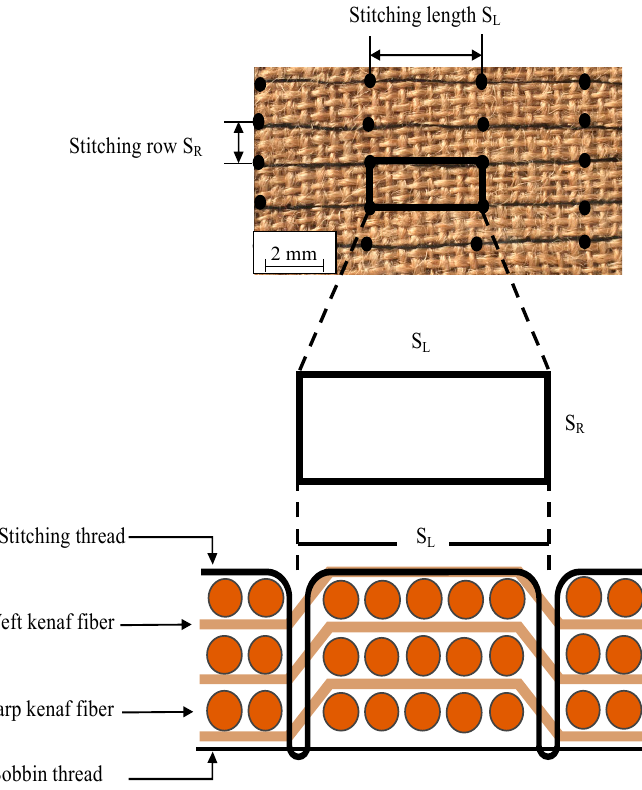
Figure 1. Woven kenaf stitching process.